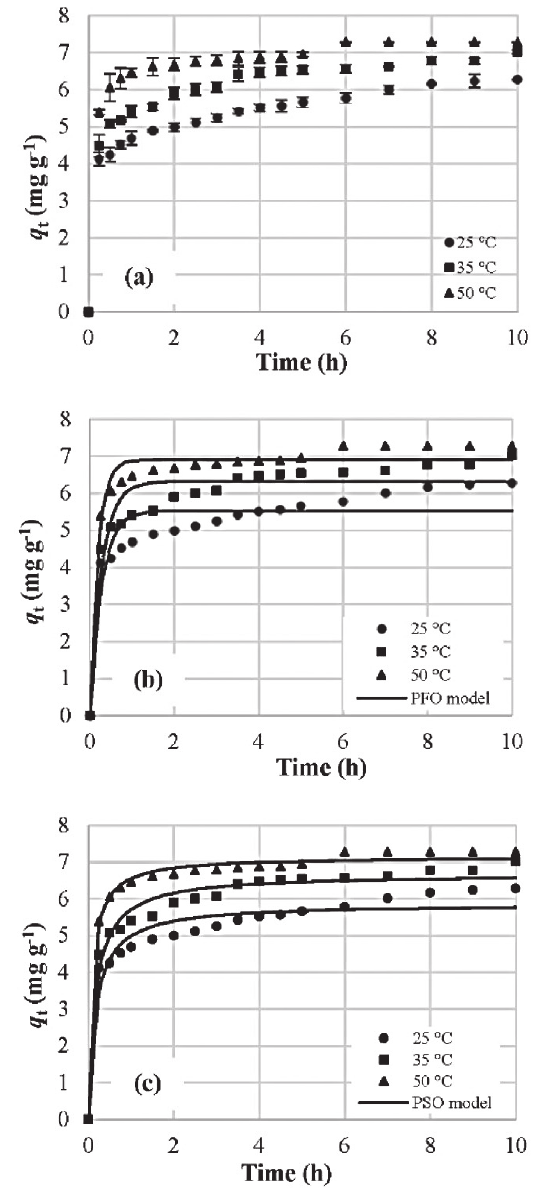
Fig. 6 – Kinetics of cefdinir adsorption on TiO adsorption temperatures (a) experimental data, fitted to (b) PFO, and (c) PSO rate models (C loadings = 1.5 g L –1 , pH =